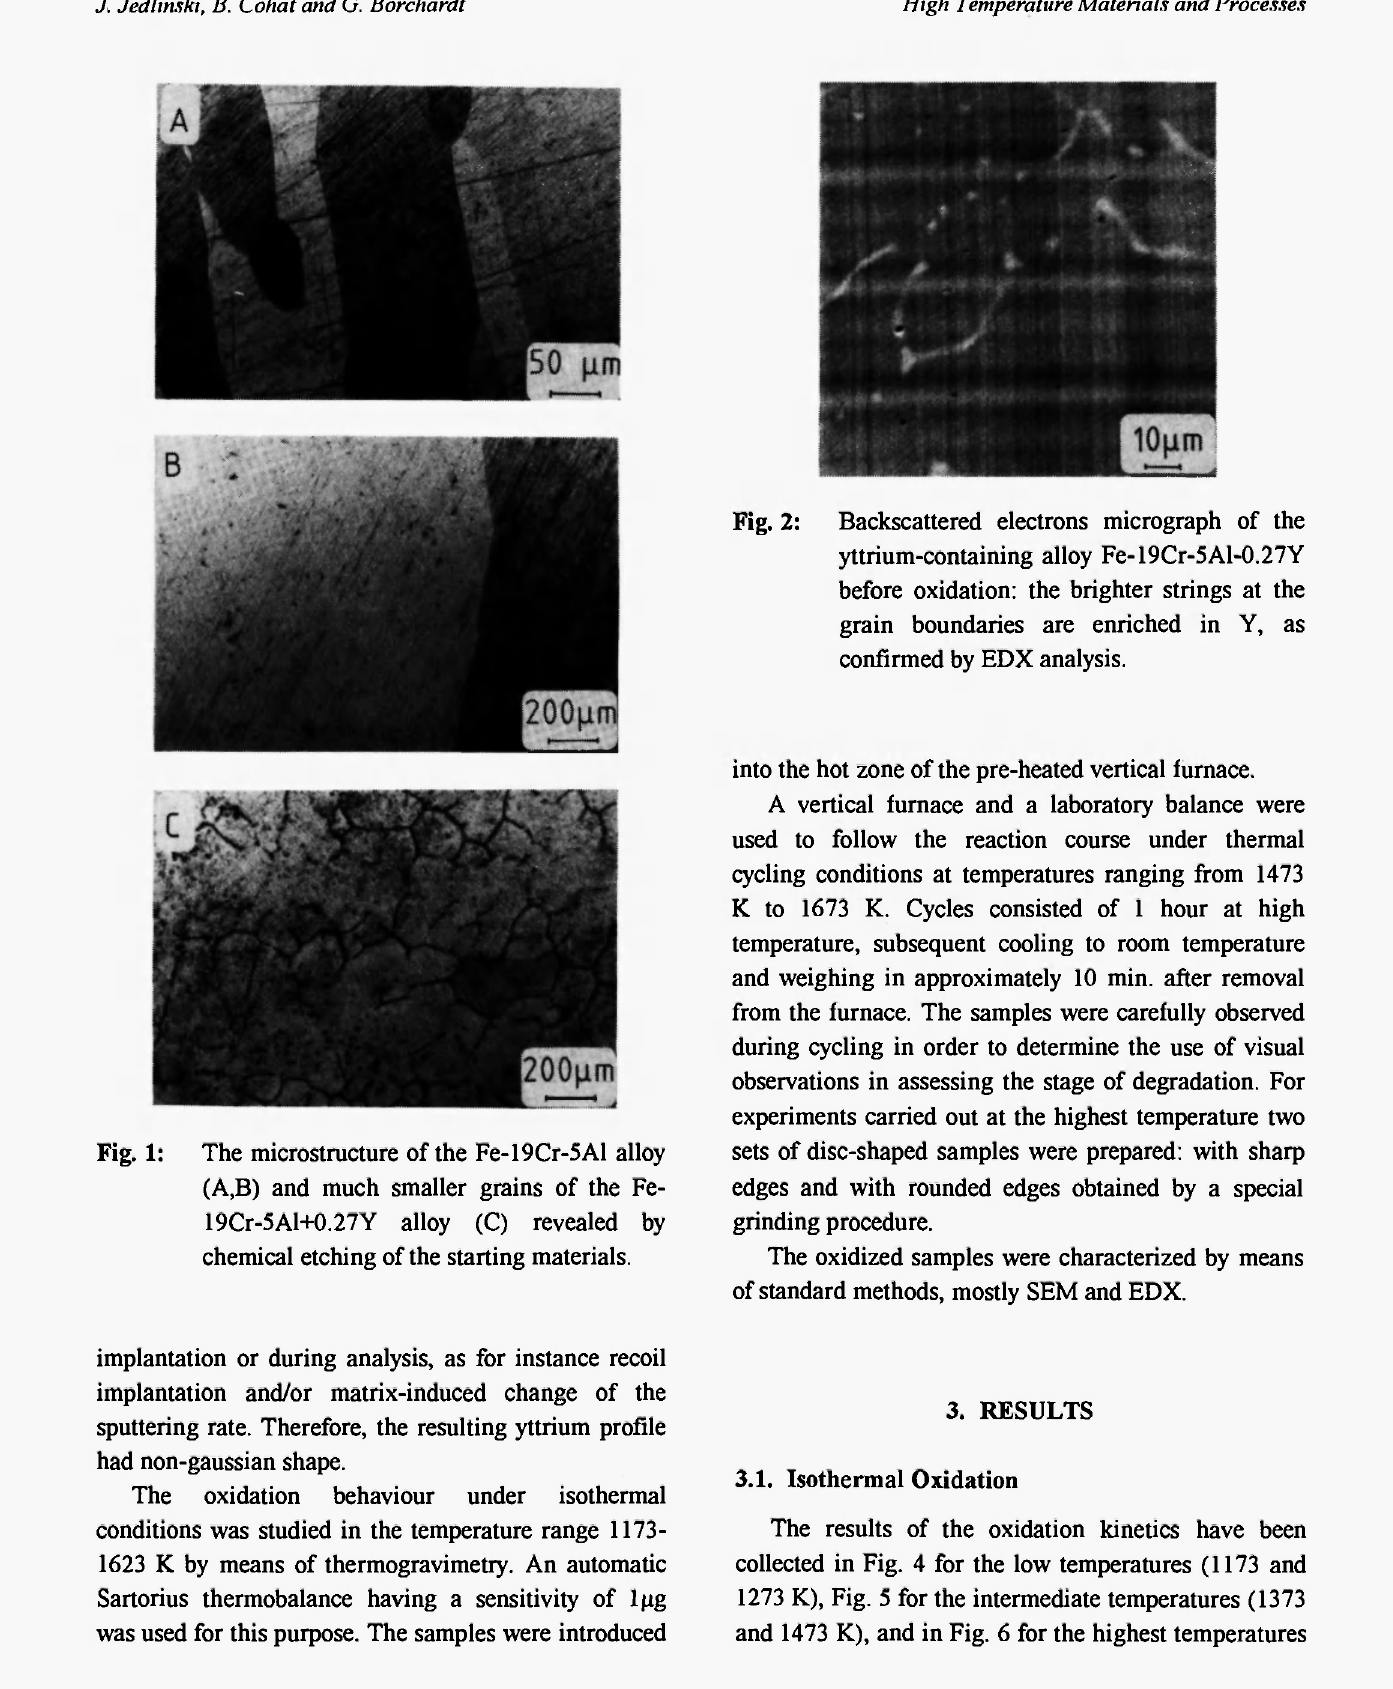
Fig. 1: The microstructure of the Fe-19Cr-5Al alloy (A,B) and much smaller grains of the Fe- 19Cr-5Al+0.27Y alloy (C) revealed by chemical etching of the starting materials.